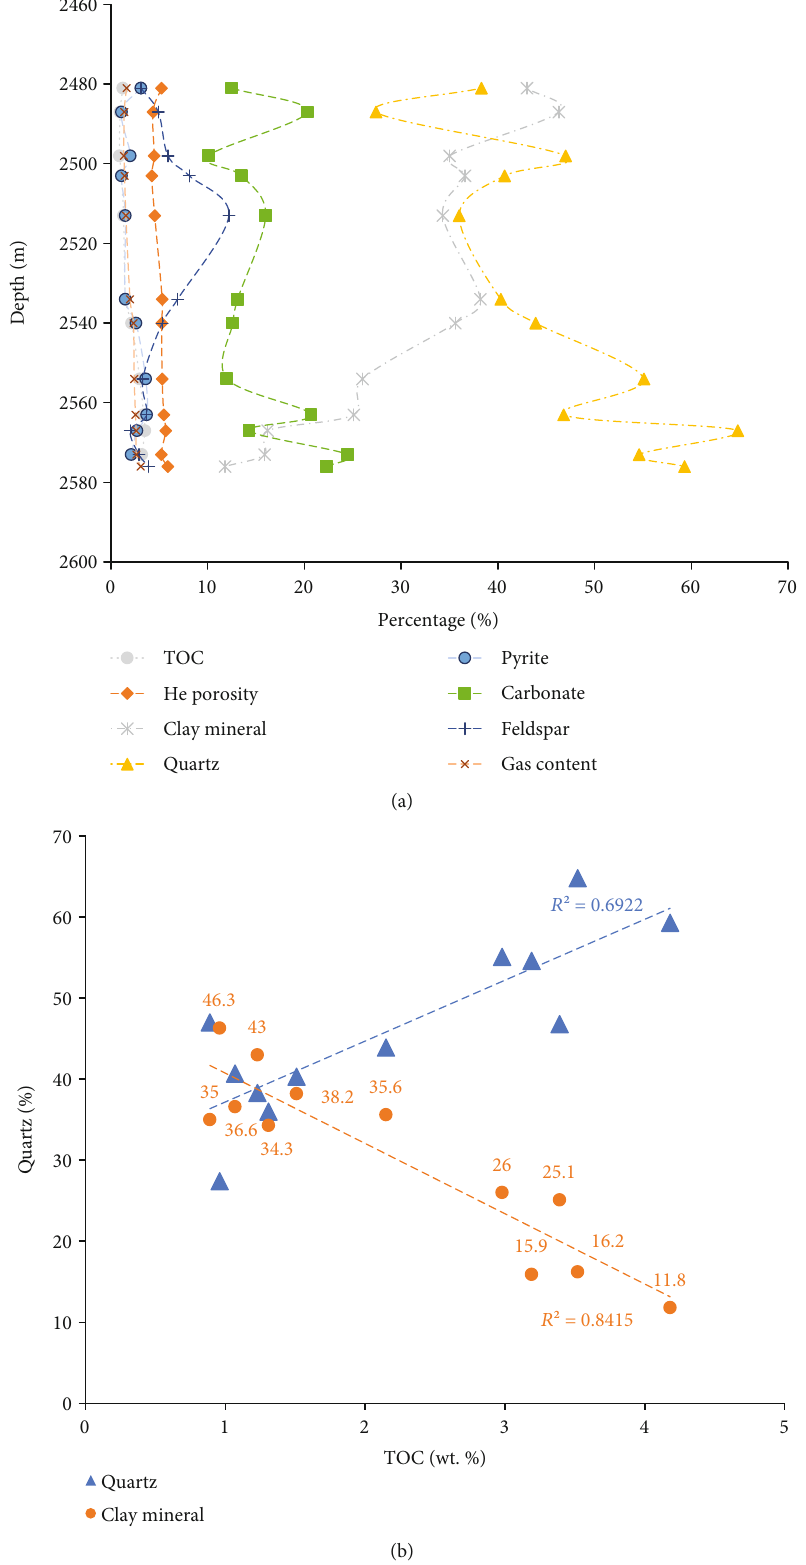
Figure 3: (a) Relationship between depth and total organic carbon (TOC) content (%), mineral content (%), helium porosity content (%), and gas content (m 3 /t) of Wufeng-Longmaxi shales. (b) Crossplot of quartz content vs. TOC content. Crossplot of clay mineral content vs. TOC content. The marked numbers are contents (%) of clay minerals of Wufeng-Longmaxi